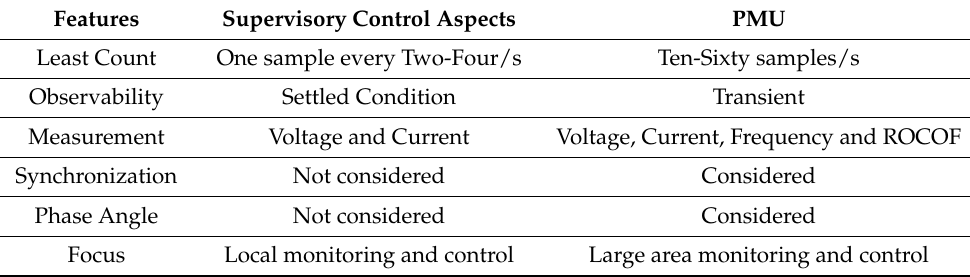
Table 4. Differences between SCADA and